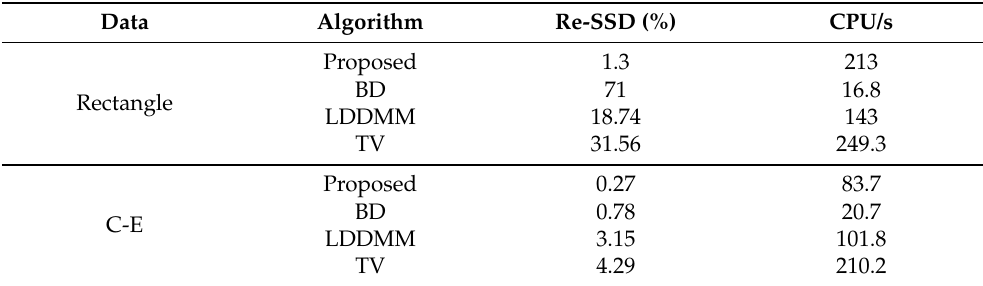
Figure 4. Registration result for different scales on image pairs C-E. ( a ) T ( · ) . ( b ) Re − SSD = 37.35%. ( c ) Re − SSD = 1.83%. ( d ) Re − SSD = 0.97%. ( e ) Re − SSD = 0.46%. ( f ) Re − SSD = 0.27%. Table 1. Quantitative comparison of registration results of four different algorithms (test for synthetic image